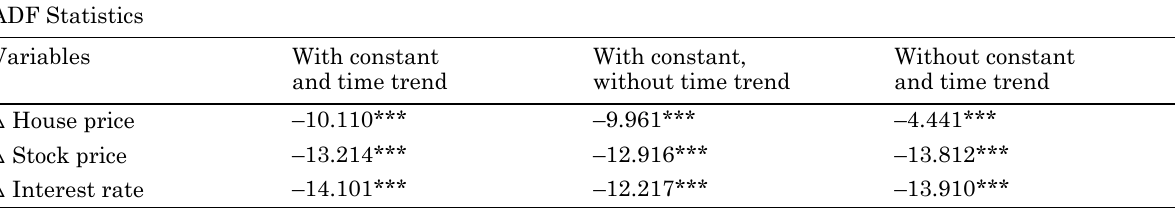
Table 3. ADf unit root test on first differencing in house price, stock price, and interest rate ADf Statistics